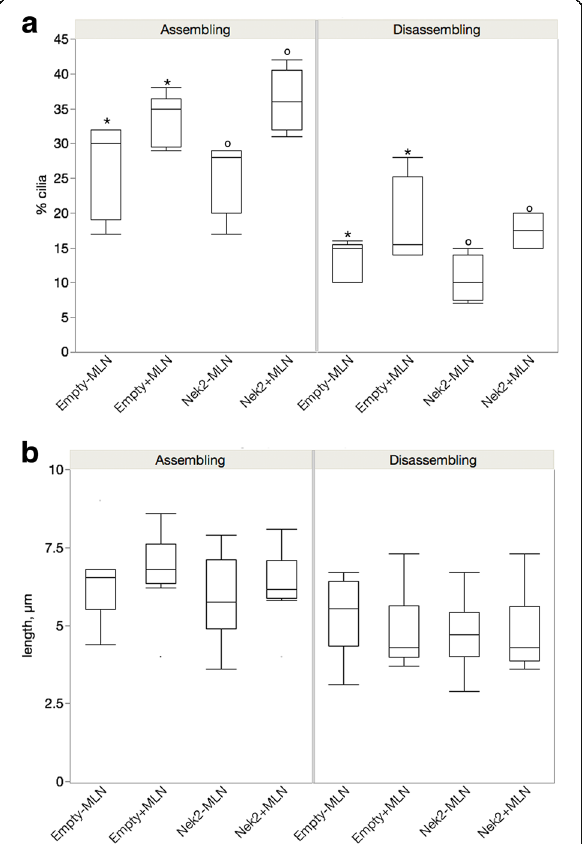
Fig. 4 AurA inhibition increases cilia number. ARPE-19 were tranfected with control vector or the Nek2 expression plasmid in the presence or absence of 0.20 μ M AurA inhibitor MLN8237, cells were serum starved to stimulate cilia formation (assembling, left panels) followed by reintroduction of serum to induce cilia disassembly (disassembling, right panels). Cilia number ( a ) and length ( b ) were measured for a total of at least 300 cells. Significant differences are indicted with similar symbols, p ≤ 0.05. The means for cilia number and length ± SEM are shown in Table